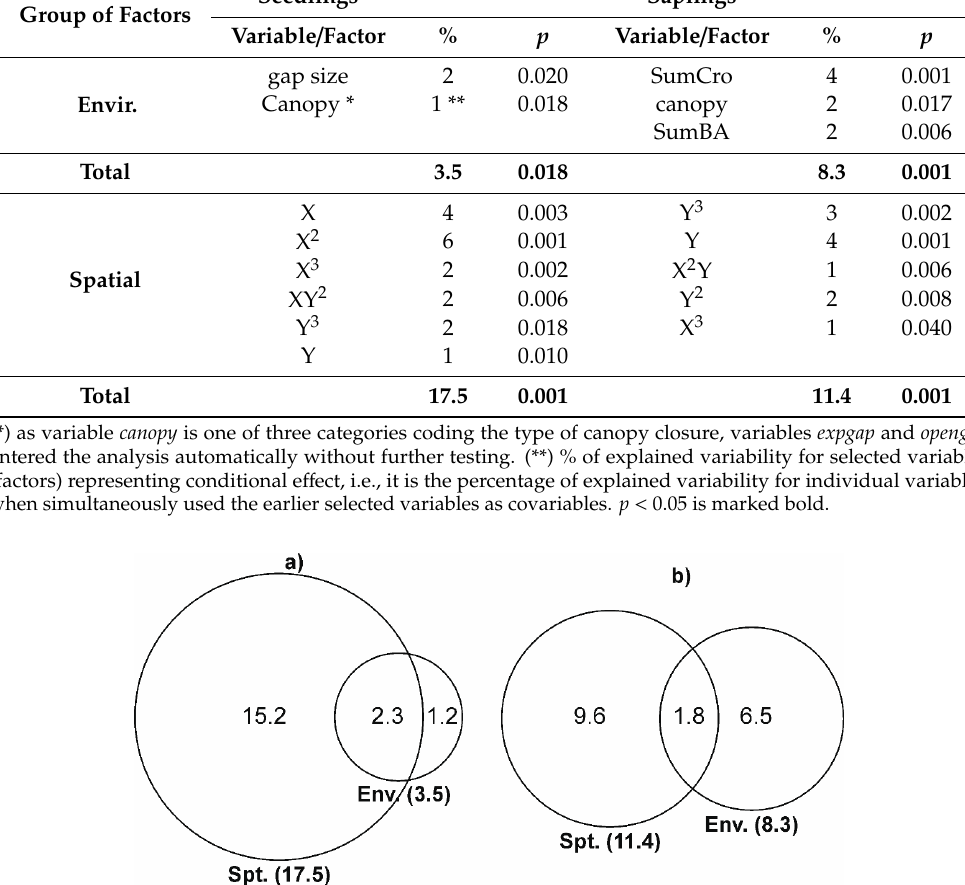
Table 7. Regresion β -coefficients obtained from general linear models for each individual tree species and height growth category of natural regeneration in relation to independent environmental factors, displayed are R-squares of the whole models and their p- values. Tree Species